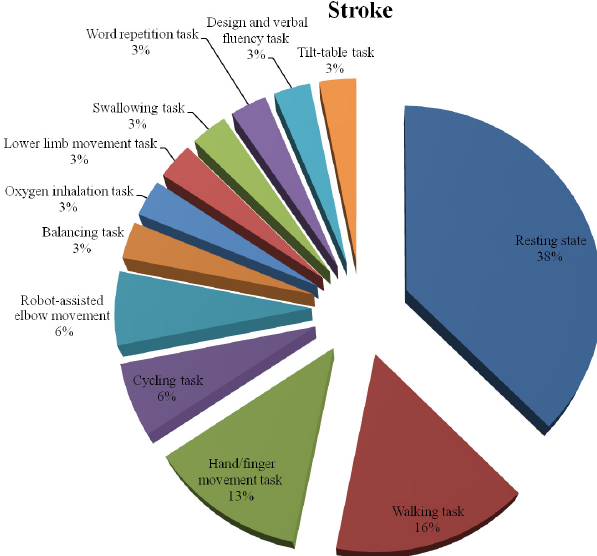
Fig. 10. Task-based distribution of studies on stroke (total studies: